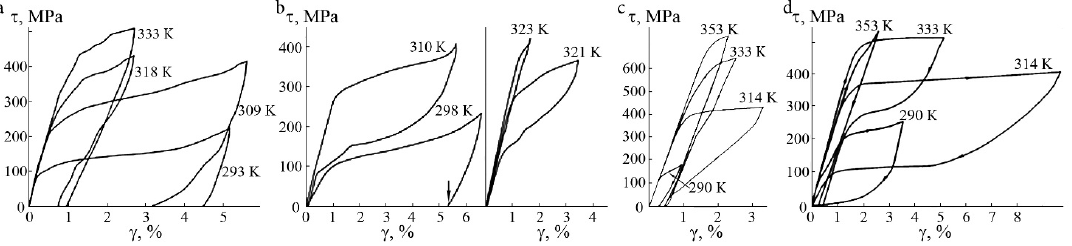
Figure 29. Accumulation and recovery of deformation in isothermal loading-unloading cycles during torsion tests of ( a , b ) CG Ti 49.4 Ni 50.6 alloy ( a ) quenched at 1073 K, and ( b ) after ECAP at 673 K, 8 passes; ( c , d ) Ti 49.8 Ni 50.2 ( c ) quenched at 1070 K, and ( d ) after ECAP at 673, 8 passes. The test temperatures are given at the curves.